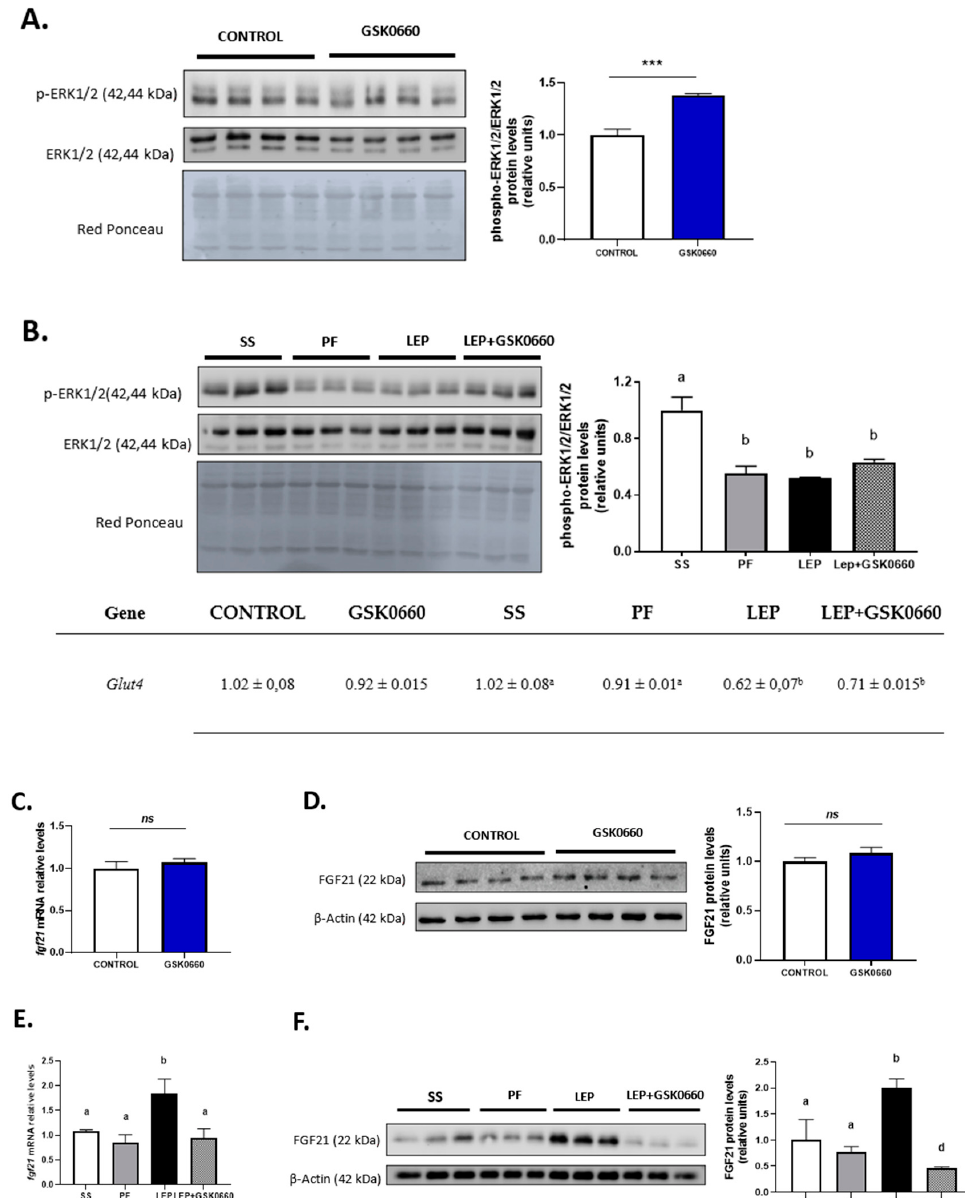
Figure 5. ( A ) Representative Western Blot of p-ERK1/2 and total ERK1/2 protein levels and relative densitometric analysis of the ratio p-ERK1/2/ERK1/2 in eWAT of rats after 7 days of vehicle (DMSO) control or intraperitoneal antagonist GSK0660 injection ( n = 6). ( B ) mRNA levels of Glut4, representative Western Blot of p-ERK1/2 and total ERK1/2 protein levels and relative densitometric analysis of the ratio p-ERK1/2/ERK1/2 in eWAT of rats after 7 days of chronic central treatment of vehicle (SS and PF), leptin, or leptin and ip GSK0660 co-administration ( n = 4–6). Effect of vehicle (DMSO) control or ip antagonist GSK0660 administration on eWAT mRNA levels ( C ) and protein levels ( D ) of FGF21 in rats after 7 days injection ( n = 6). Effect of icv vehicle (SS and PF), leptin, or leptin and ip GSK0060 co-administration on eWAT mRNA levels ( E ) and protein levels ( F ) of FGF21 in rats after 7 days of chronic treatment ( n = 4–6). Data from real-time RT-PCR are expressed relative to 18S rRNA and the mRNA levels are expressed relative to the Control group and SS group, the level of which was set at 1.0 arbitrarily. In Western blot analysis, densitometric levels of proteins are expressed relative to the Control group and SS group, the levels of which were set at 1.0 arbitrarily. Results are the mean ± SEM per group of animals ( n = 4–6). Differences between CONTROL vs. GSK0660 treatment were analyzed by Student’s t -test (*** p < 0.001). Significant differences between ICV-treated rats were analyzed by One-Way ANOVA followed by Tukey test (differences letters mean significant differences among treatments, p ≤ 0.05). a p ≤ 0.05 vs. Lep or Lep+GSK0660; b p ≤ 0.05 vs. SS or PF or Lep+GSK0660; c p ≤ 0.05 vs. SS or PF or Lep. SS: vehicle-infused rats fed ad libitum, PF: vehicle-infused pair-fed rats; Lep: leptin-infused rats; Lep+GSK0660: leptin-infused rats plus PPAR β / δ antagonist